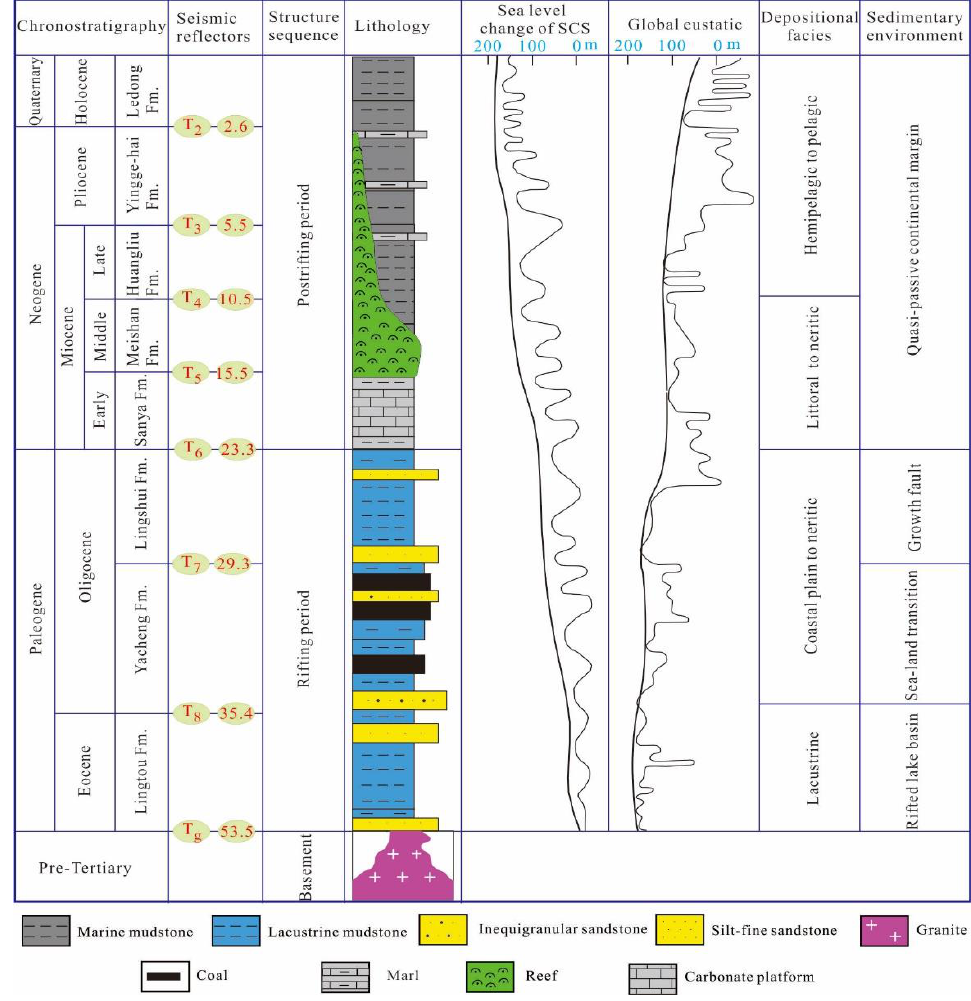
Figure 2. Stratigraphic column of the Xisha sea area and major tectonic events in the South China Sea. The ages of the seismic surfaces are based on the results of previous research [13], and the curve of global sea level changes is from [20].